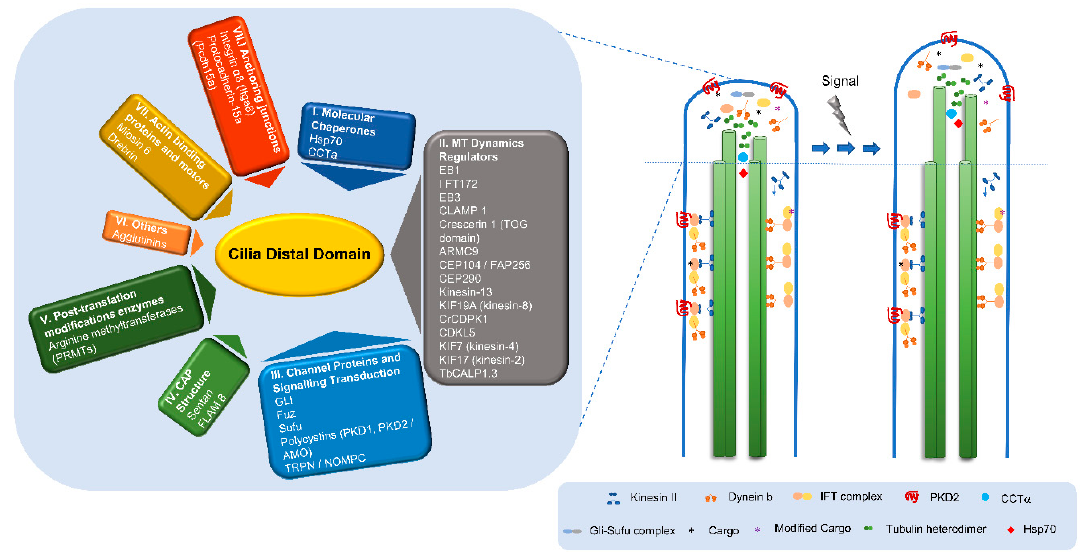
Figure 5. The dynamic distal domain and associated proteins. Important events in cilia function occur at their distal domain like cilia assembly/disassembly, intraflagellar transport (IFT) complexes’ remodeling, and signal reception/transduction. The IFT system forms cargo-carrying trains moved along the axoneme through the action of kinesin-2 (anterograde) and dynein-2 (retrograde) motors. This transport is essential for the assembly and maintenance of cilia and flagella. Tubulin subunits are transported throughout the cilium by IFT. At the tip, IFT trains split apart and mix with each other to assemble into new trains, which move back to the cell body with new cargos. Kinesin transports dynein to the tip as inactive cargo, disconnects from IFT trains at the tip and turns around by diffusion. Distinct functional arrays of ciliary proteins that concentrate at the tip are indicated (Molecular chaperones, Microtubule dynamic regulators, Channel proteins and signaling transduction, Cap structural proteins (when cap structures are present), Post-translational modifications enzymes, Actin binding proteins and motors, Anchoring junctions and others). A-tubule singlets are in general characteristic of the distal domain and present a dynamic behavior by polymerization and depolymerization, therefore changing the tip segment length in response to different signals.